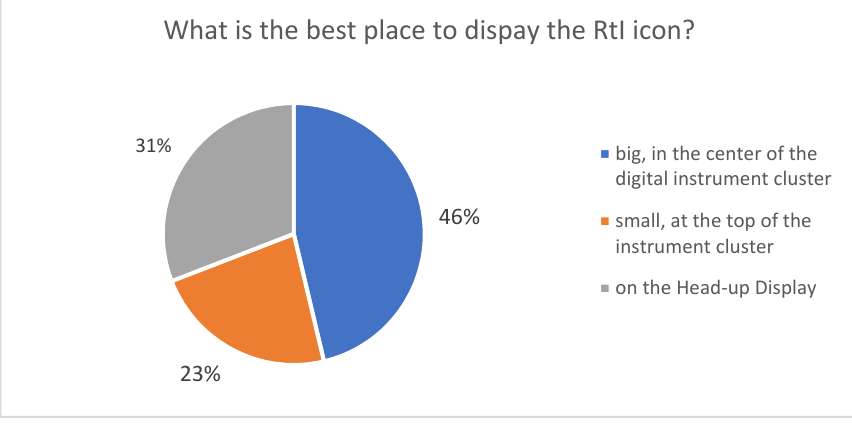
Figure 8. Preferred location of the RtI icon.